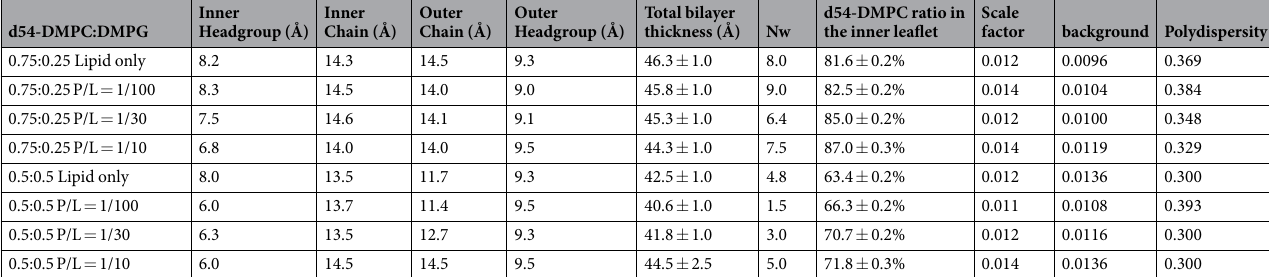
Table 1. Structural parameters obtained by model fitting. The total bilayer thickness is the sum of the head group and the chain thickness of both inner and outer leaflets. The thickness of various shells is correlated; therefore, the total bilayer thickness and its uncertainty are more meaningful parameters. N w is the number of water associated per lipid head